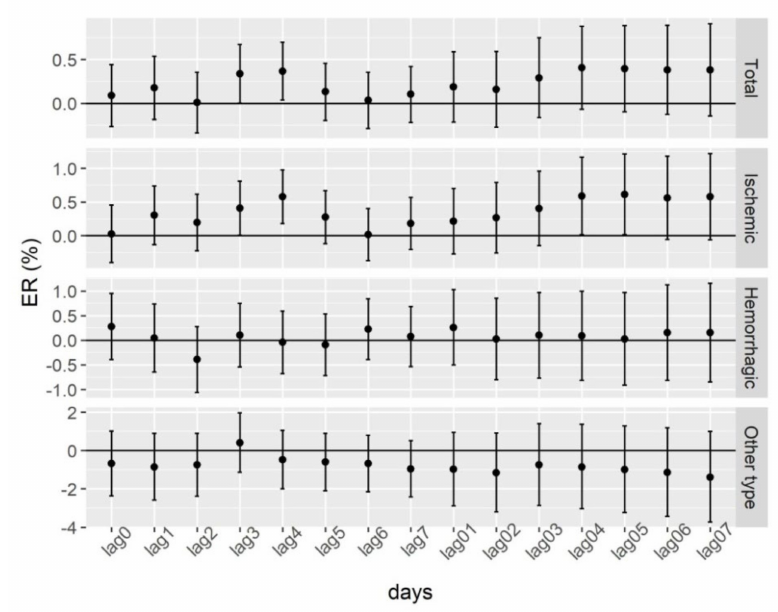
Figure 2. ER and 95% CI of daily incidence of different subtypes of stroke associated with one-unit (1 µ g/m 3 ) increase in NO 2 . Single-day lag effects: lag0, lag1, lag2, lag3, lag4, lag5, lag6, and lag7 (lag0 corresponds to the current-day air-pollutant concentration, and lag1 refers to the average concentration of air pollutants on the day before stroke incidence, etc.). Cumulative lag effects: lag01, lag02, lag03, lag04, lag05, lag06, and lag07 (the lag01 corresponds to the 2-day moving average concentration of air pollutants concentrations on the present day and previous day,